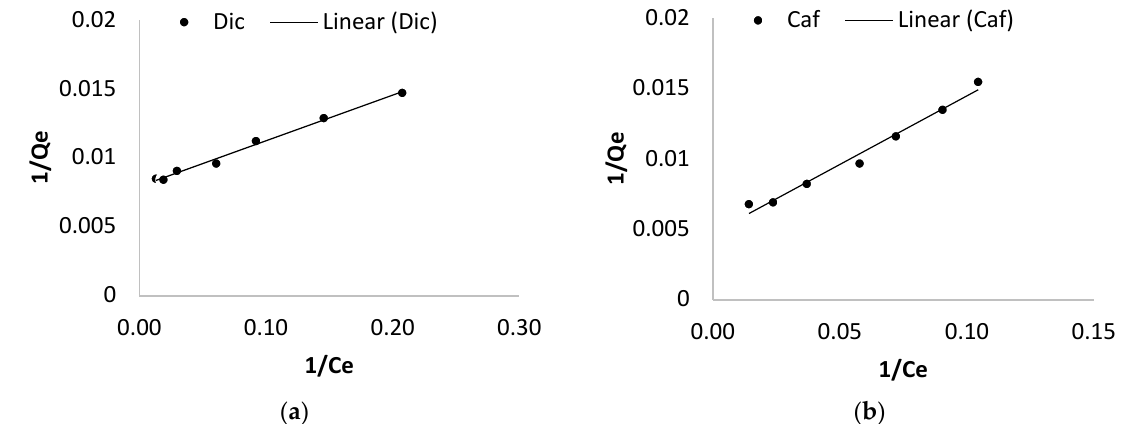
Figure 9. Langmuir isotherm of Dic ( a ) and Caf ( b ) on AC based on argan nutshells.